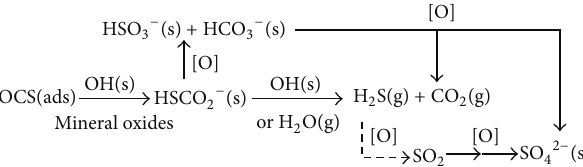
Figure 3: The concerted mechanism as proposed by He et al. [9, 24–